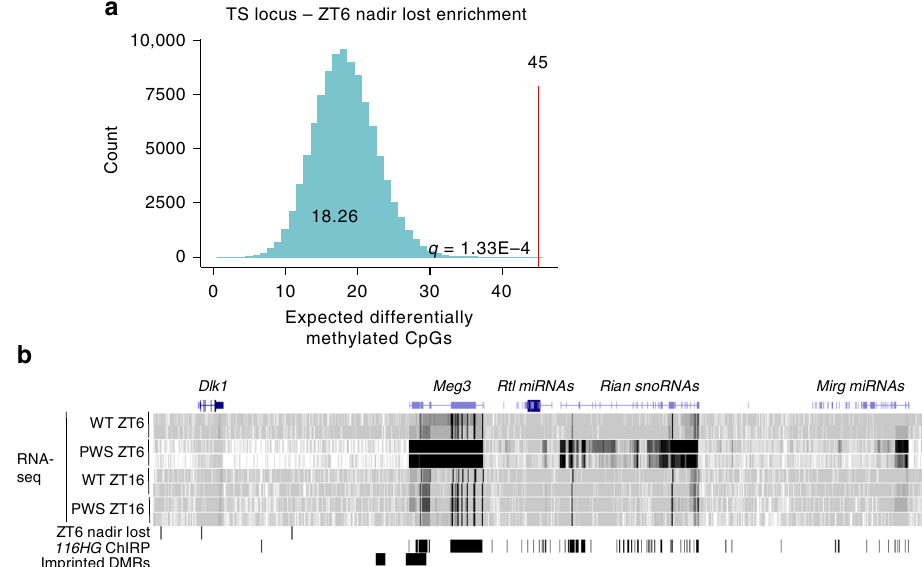
Fig. 6 The imprinted TS locus is enriched for dysregulated diurnal methylation and expression in Snord116 + / − cortex. a CpGs which lose their DNA methylation nadir at ZT6 with the loss of Snord116 show the greatest enrichment at the TS locus compared to all imprinted loci (Fisher ’ s exact test with Benjamini – Hochberg correction, q = 1.33 × 10 − 4 ). (See Supplementary Data 9 for full imprinted loci enrichment analysis). b UCSC Genome Browser view of the expression pro fi le and 116HG ChIRP binding peaks across the TS locus. The PWS 116HG RNA cloud colocalizes with the TS locus and loss of Snord116 results in the upregulation of TS locus genes speci fi cally during light hours